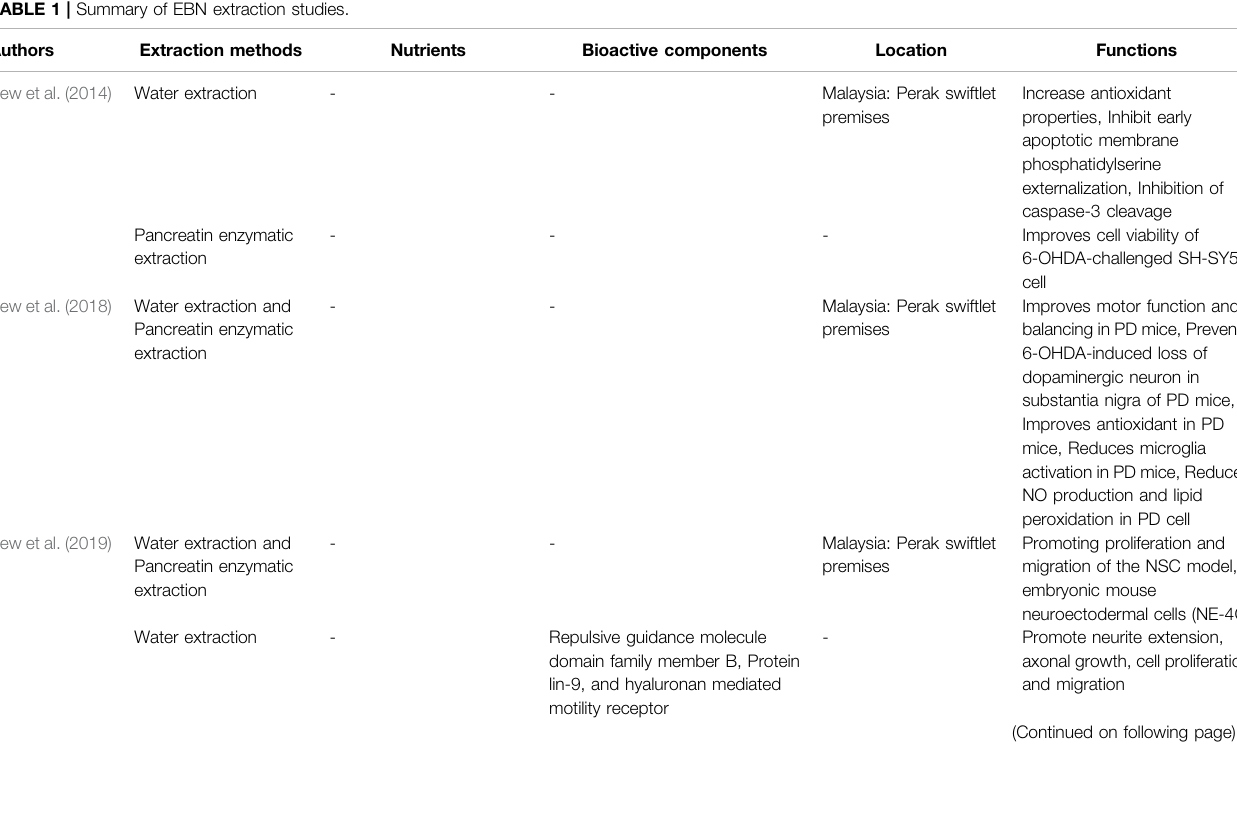
TABLE 1 | Summary of EBN extraction